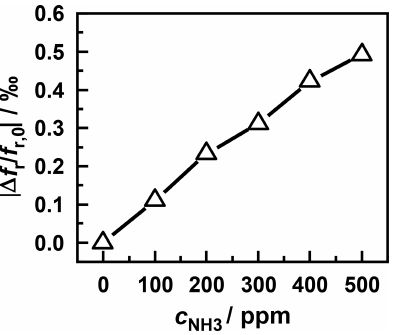
Figure 9. Frequency shift caused by different ammonia concentra- tions at a sensor temperature of 310 ◦